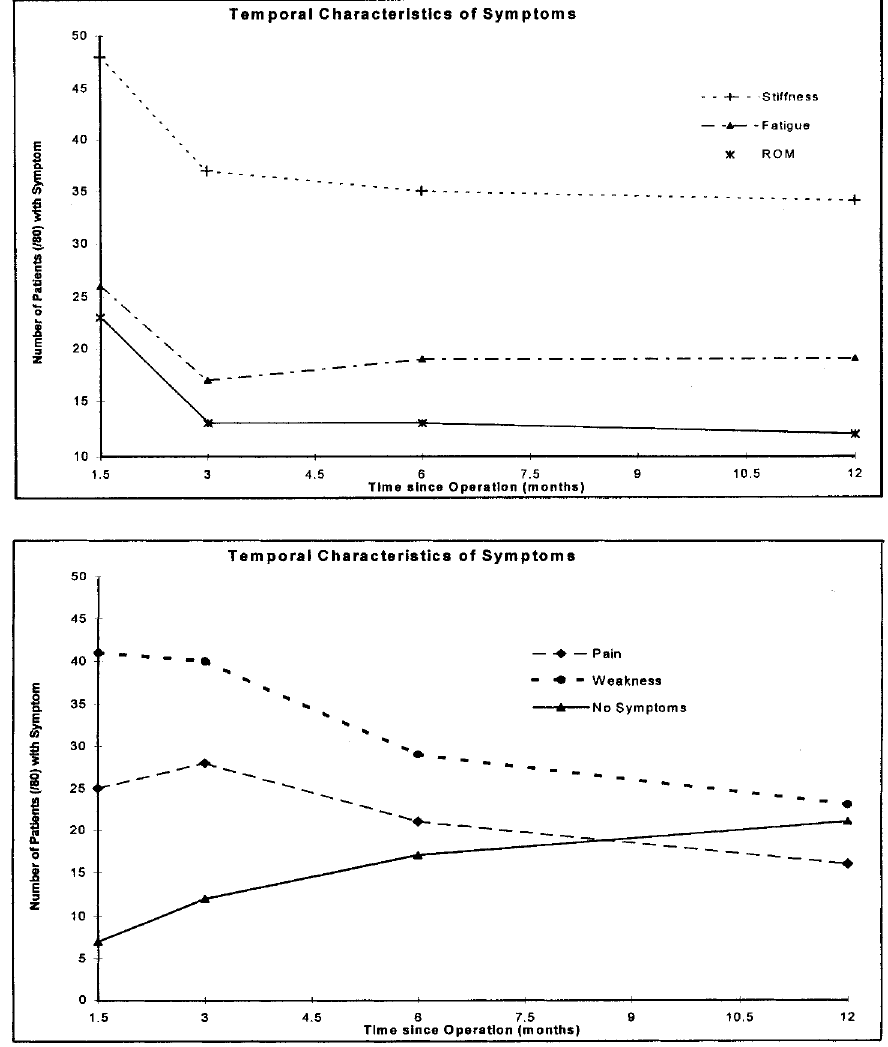
Figure 1 Frequency of symptoms over time following limb preservation surgery for lower extremity sarcoma. (a) Symptoms with a plateau in frequency over time. (b) Symptoms decreasing in frequency over